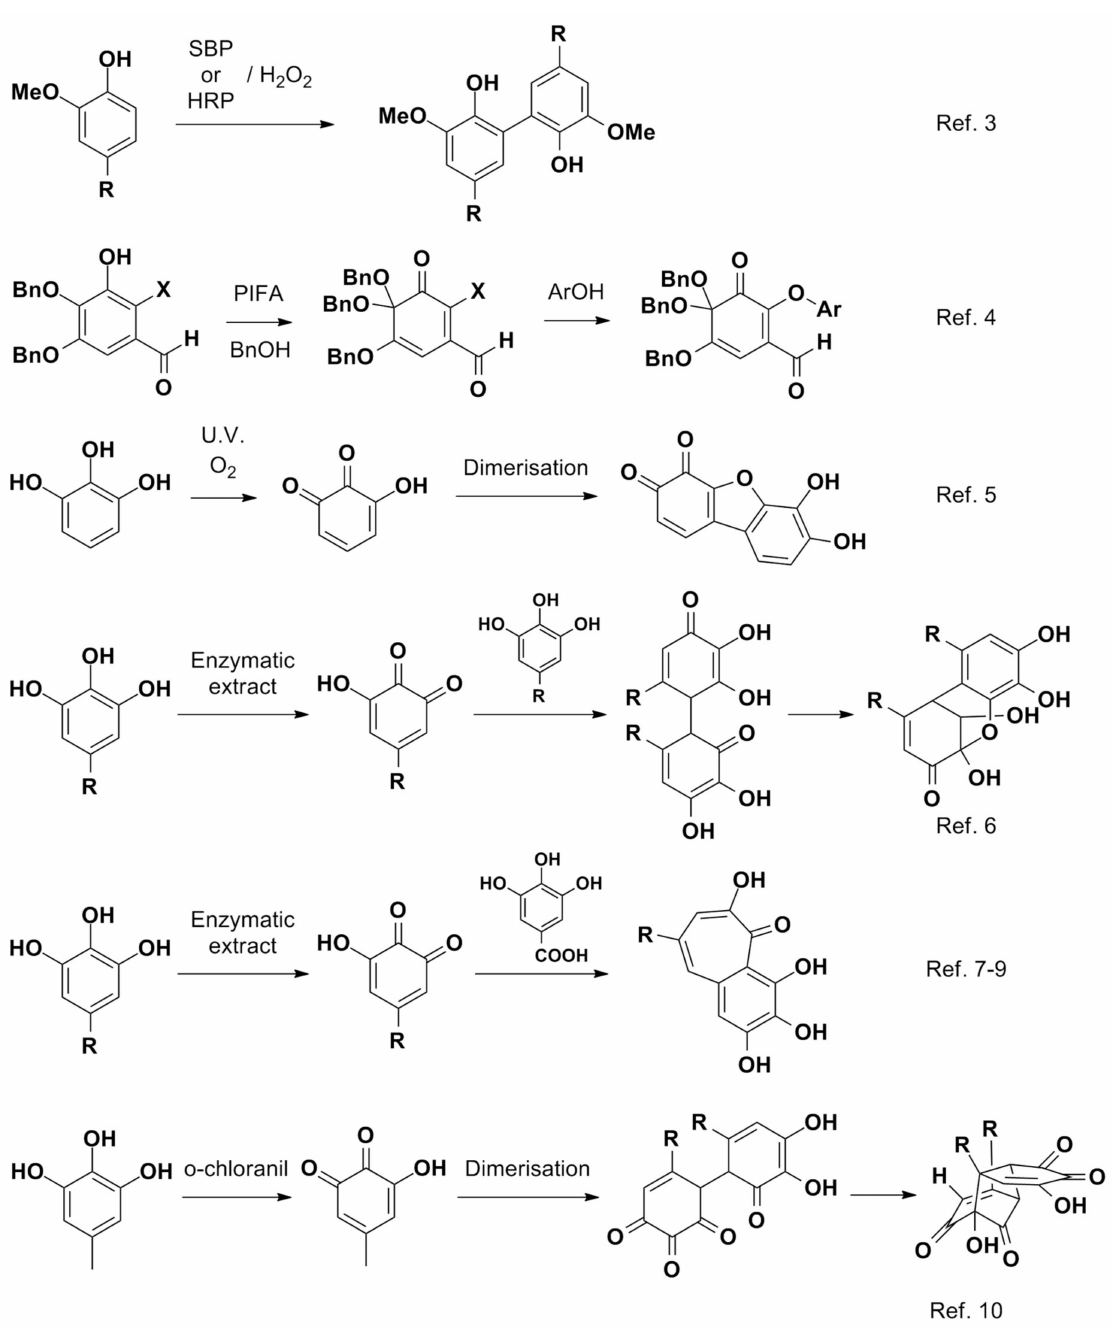
Scheme 1. Most common oxidation products of mono-aromatic